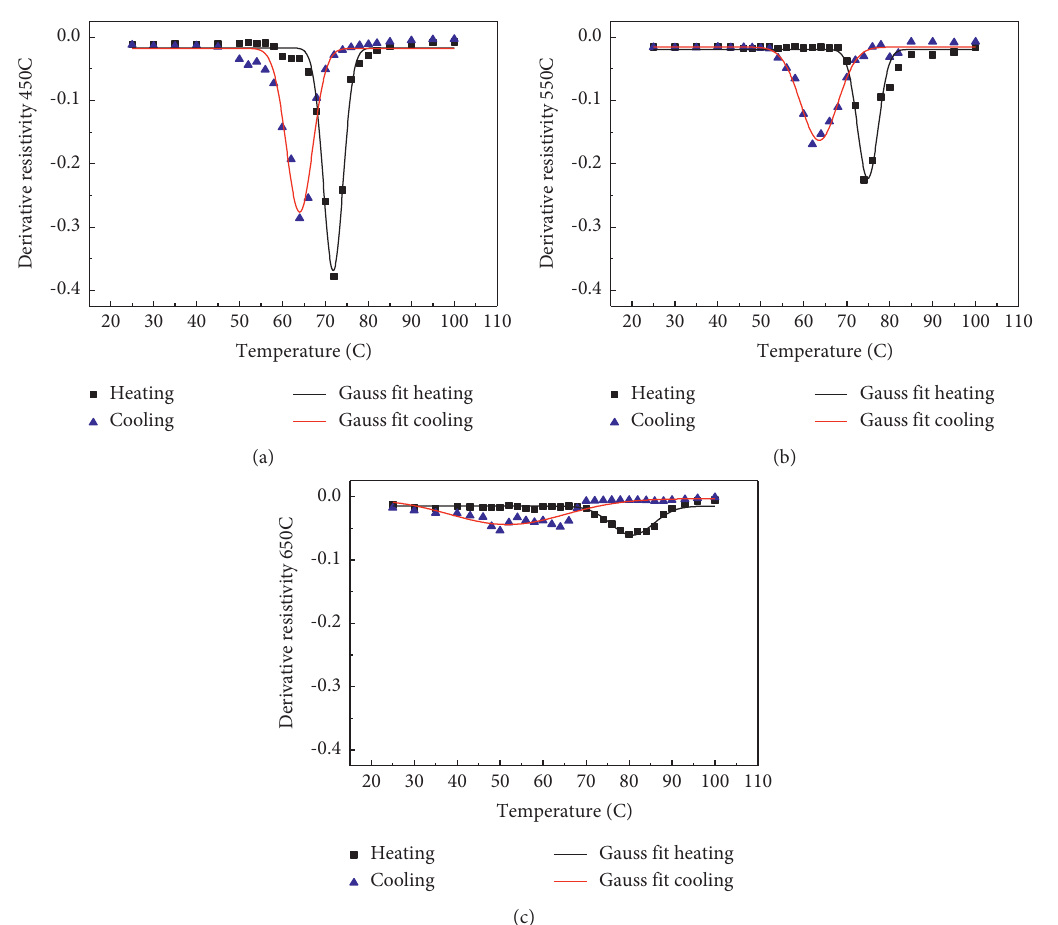
Figure 5: Derivative of the resistivity versus temperature of the PLD VO (a) 450 ° C, (b) 550 ° C, and (c) 650 °